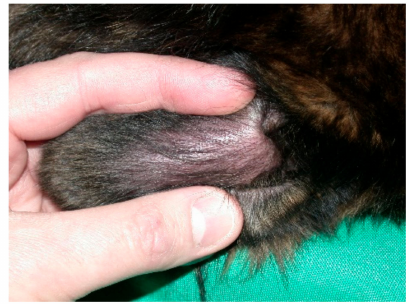
Figure 3. Aural haematoma in the pinna of a dog. Courtesy Dr. Stephen Baines, Willows Referral Service, Highlands Road Shirley, Solihull B90 4NH,